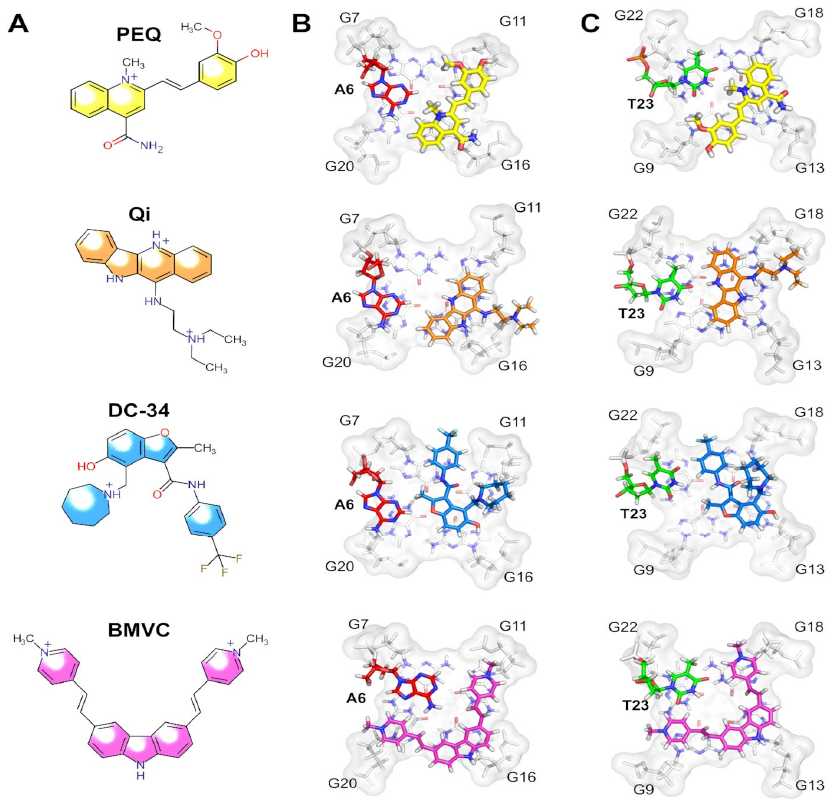
Figure 13. High-resolution structures of Myc2345_T23 in complex with PEQ, Quindoline-I, DC-34 and BMVC. ( A ) Common names and chemical structures of the ligands. Binding of each ligand to the ( B ) 5 ′ -G-tetrad and ( C ) 3 ′ -G-tetrad of Myc2345_T23. Reprinted from ref. [153].